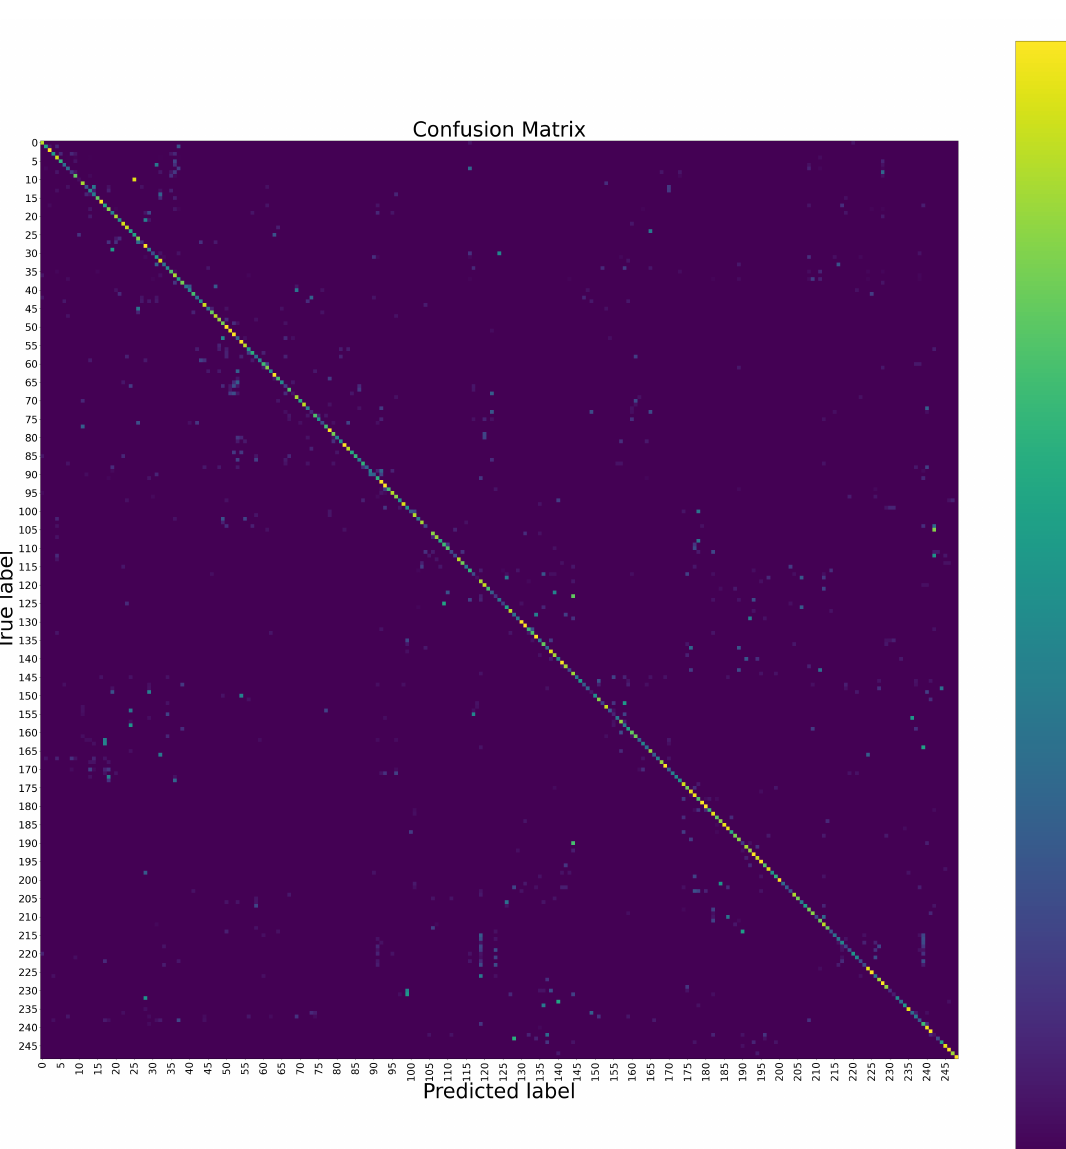
Figure 6. The confusion matrix of the proposed method for the fusion of the hand level and the body level on the Chalearn LAP IsoGD dataset. To see the details, please zoom